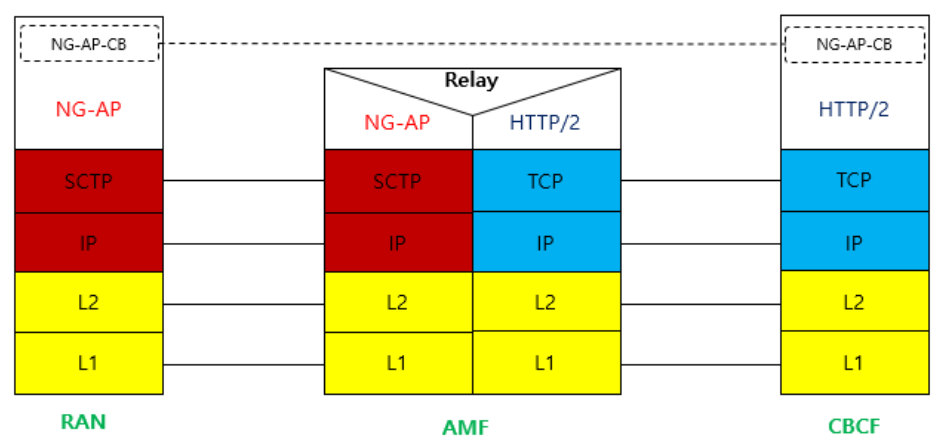
Figure 2. The network protocols for the CBS message transfer from CBCF to base station (RAN).